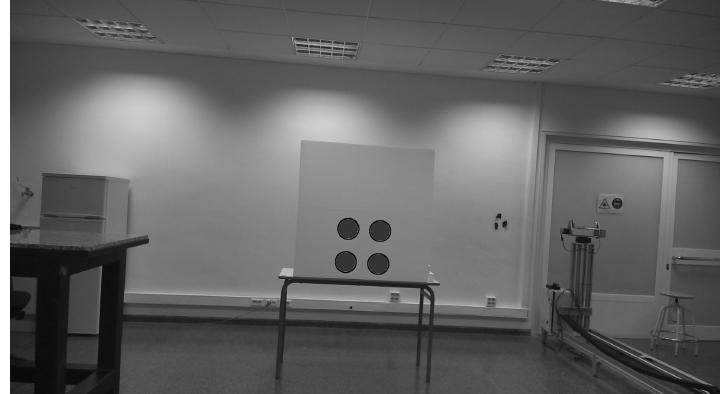
Figure 9. The RGB image of the calibration board.